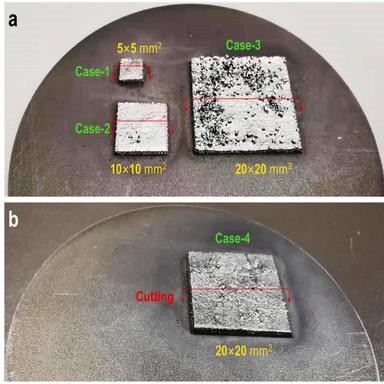
Square SS304-IN718-SS304 MMS plates with different sizes fabricated by MAPS with the building strategies of (a) 90◦ rotation scanning and (b) island scanning strategy.